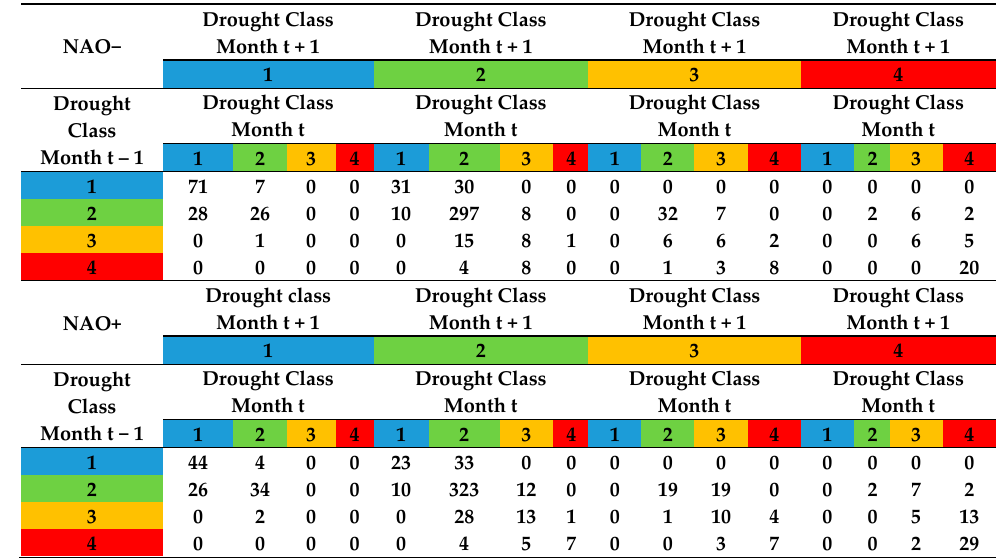
Table 5. Counts of two consecutive transitions between drought classes of SPEI12 (t − 1 → t → t + 1) for NAO − and NAO+.